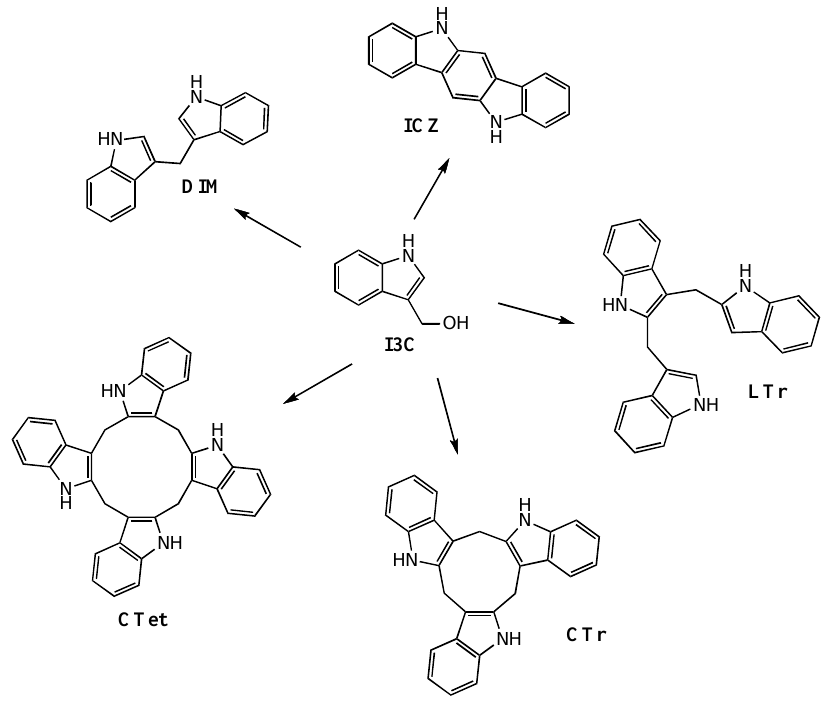
Figure 1. Chemical structures of compounds I3C , DIM , ICZ , LTr , CTr , and CTet